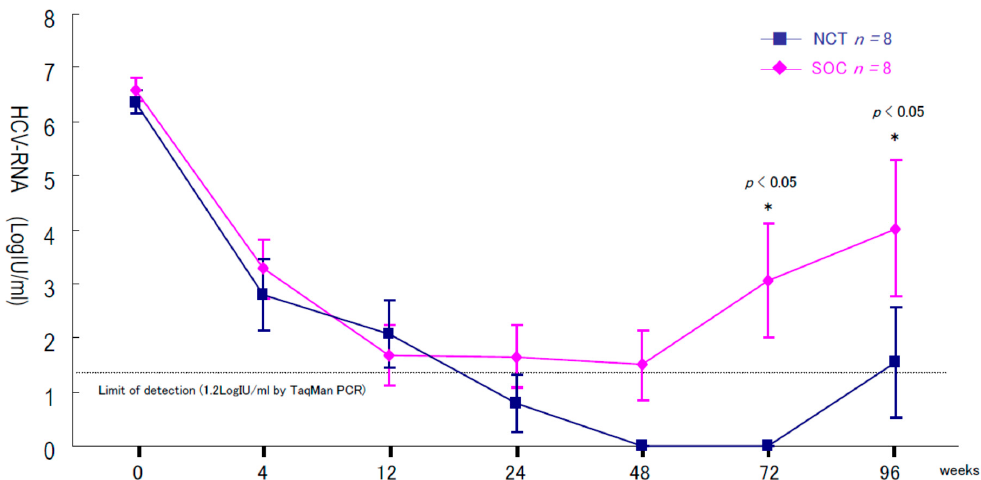
Figure 1. Changes in serum hepatitis C virus (HCV).RNA level during and after the NCT and the SOC in chronic hepatitis C patients with genotype 1b and high viral loads. NCT: novel combination treatment (NCT) consists of induction therapy with natural IFN-beta followed by the SOC. SOC: standard of care (SOC) consists of PegIFN-alpha 2b plus ribavirin (RBV).